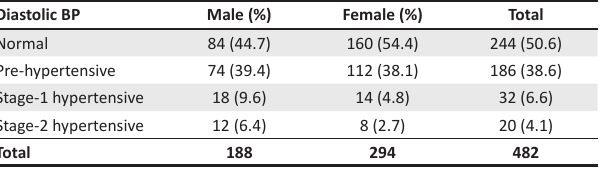
TABLE 4: Diastolic blood pressure classification of the study population. Diastolic BP Male (%) Total Normal